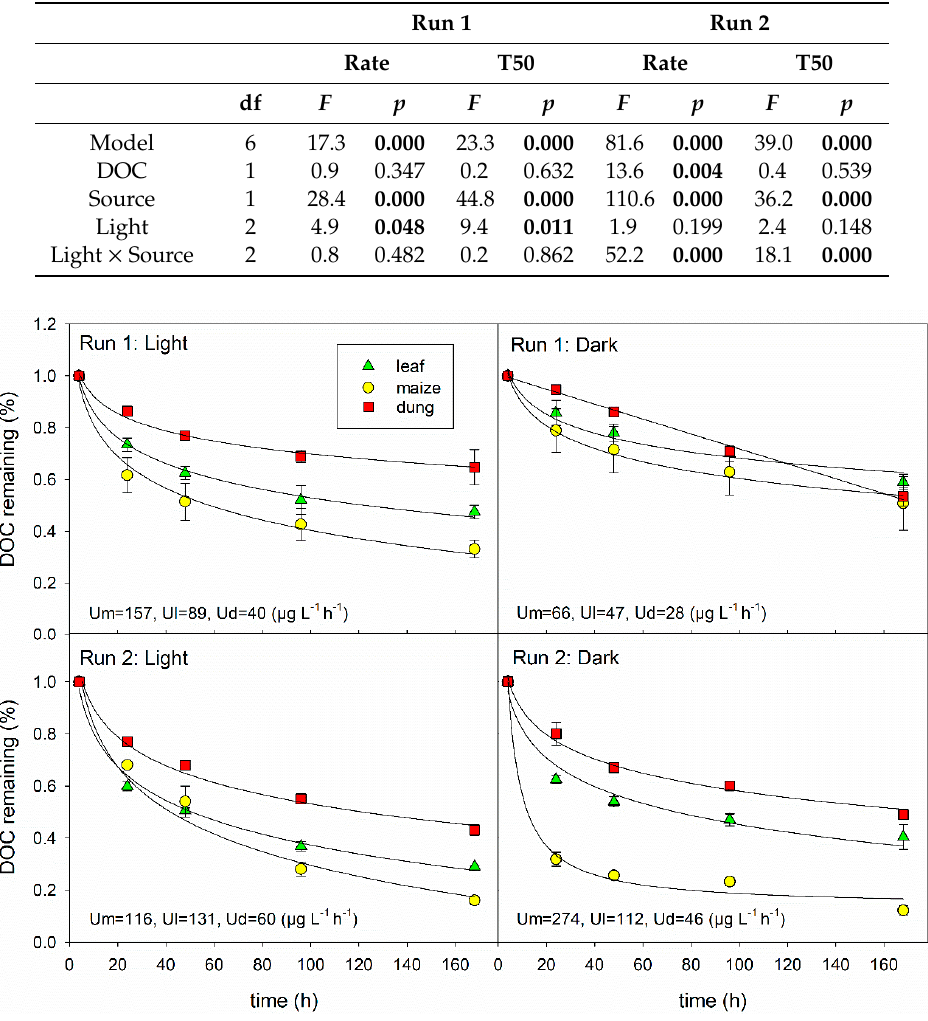
Table 3. Results of the ANCOVA regarding the e ff ects of source (leaf, maize, dung), light (light, dark), and initial DOC concentrations on the DOC uptake rate and T50 (time until 50% DOC degradation). Shown are degrees of freedom (df), F -values, and probabilities ( p ; significant di ff erences are marked in bold; n = 18 per run). Run 1 Run 2 run 1, changes in the spectroscopic properties differed between light conditions in both leaf and dung treatments, indicating that the community composition also affected the changes of DOM composition there. While the control was relatively stable throughout run 2, the spectroscopic properties showed similar changes as the treatments in run 1 (Figure 3b,c).